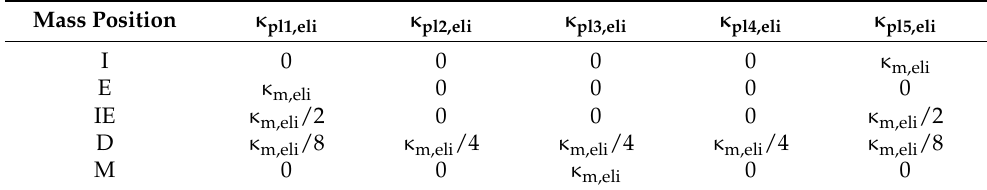
Table 1. Values of the thermal capacities of the nodes as a function of the position of the mass, as defined in EN ISO 52016. Adapted from EN ISO 52016-1:2017.